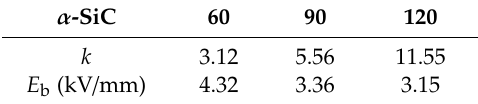
Table 4. The non-linear coefficient k and the threshold field E b of the samples with different α -SiC contents.